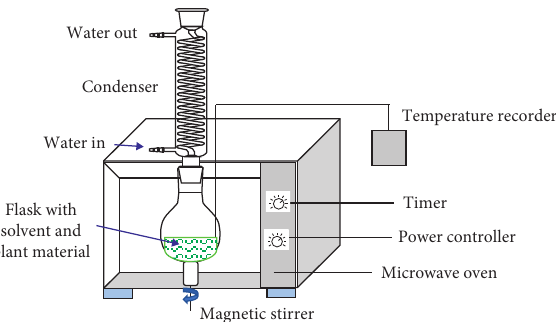
Figure 9: Scheme of a general MWAE